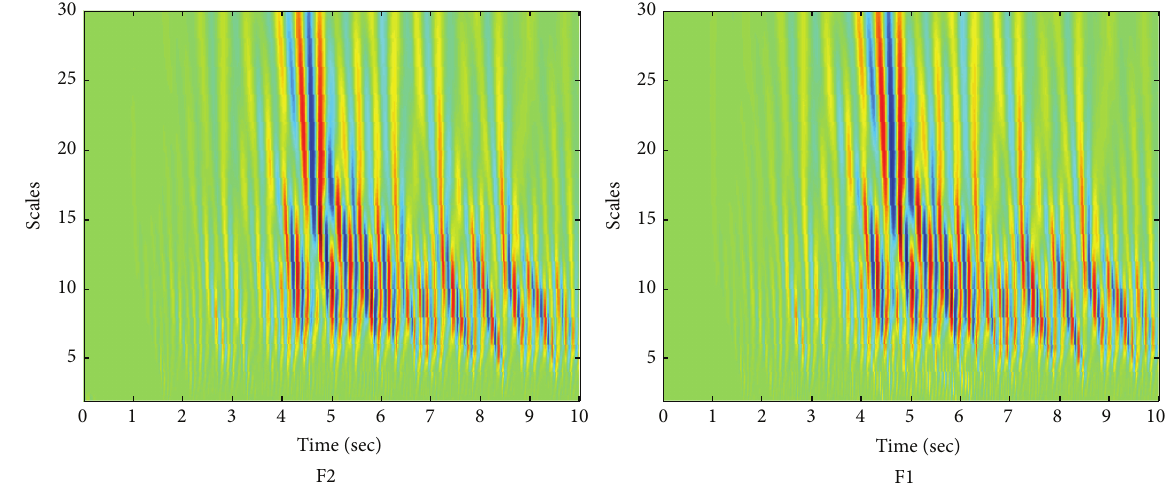
Figure 5: Regular damage D2 performance